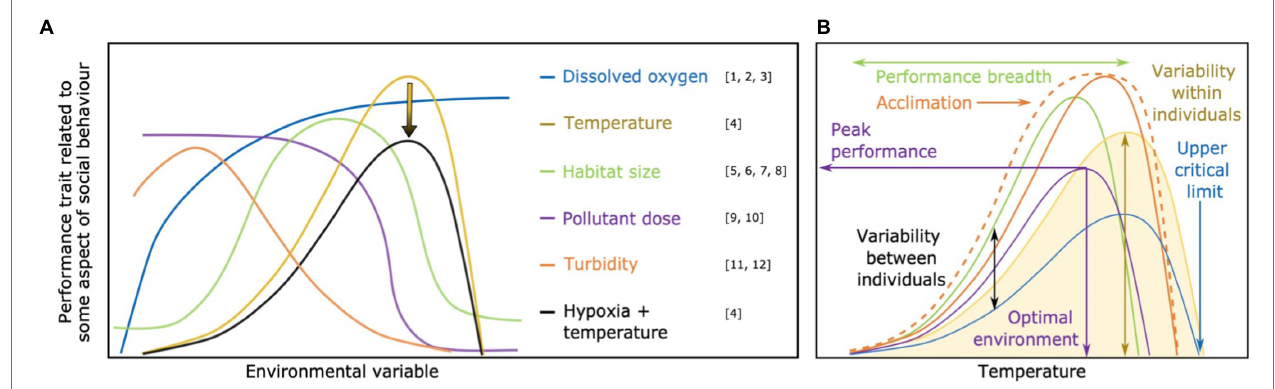
FIGURE 1 | (A) Performance curve shape is heavily dependent on the environmental factor being examined. In this panel, different types of environmental factors are represented by different colors. The arrow represents an overall depression of trait expression when potential effects of hypoxia are combined with the effects of temperature. Note, when habitat size increases, greater protection/space to hide from predators and/or increase food availability may enhance performance, thus reducing endocrine stress level (Breves and Specker, 2005; Bauer et al., 2013). However, when territory is very large the performance traits may be reduced again in territorial animals (e.g., anemonefish; Ross, 1978) due to increased stress and/or energy investment to protect a larger area from competitors or predators. (B) Potential effects of among-individual variation in performance curves for a trait related to the expression of social behavior (e.g., aerobic capacity, cognitive ability, locomotor capacity, muscular function) in response to temperature (environmental variable). In this panel, the performance curve of different individuals within a social group are represented in different colors. The dashed orange line shows variation in the performance curve (solid orange line) caused by acclimation to the environmental variable (temperature in this example). Acclimation generally results in an overall “flattening” of the performance curve, but may also cause an increase in the peak performance. Arrows illustrate the different points of individual variation in performance curve that have implications for animal social behavior, especially in ectotherms. Each point and its consequence on social behavior is highlighted in Figures 2 – 7 . References: [1] Barrionuevo and Burggren (1999); [2] Fry (1971); [3] Pörtner (2010); [4] Pörtner and Farrell (2008); [5] Maierdiyali et al. (2020); [6] Bauer et al. (2013); [7] Breves and Specker (2005); [8] Ross (1978); [9] Gomez Isaza et al. (2020); [10] McKenzie et al. (2007); [11] Meager et al. (2006); [12] Chamberlain and Ioannou